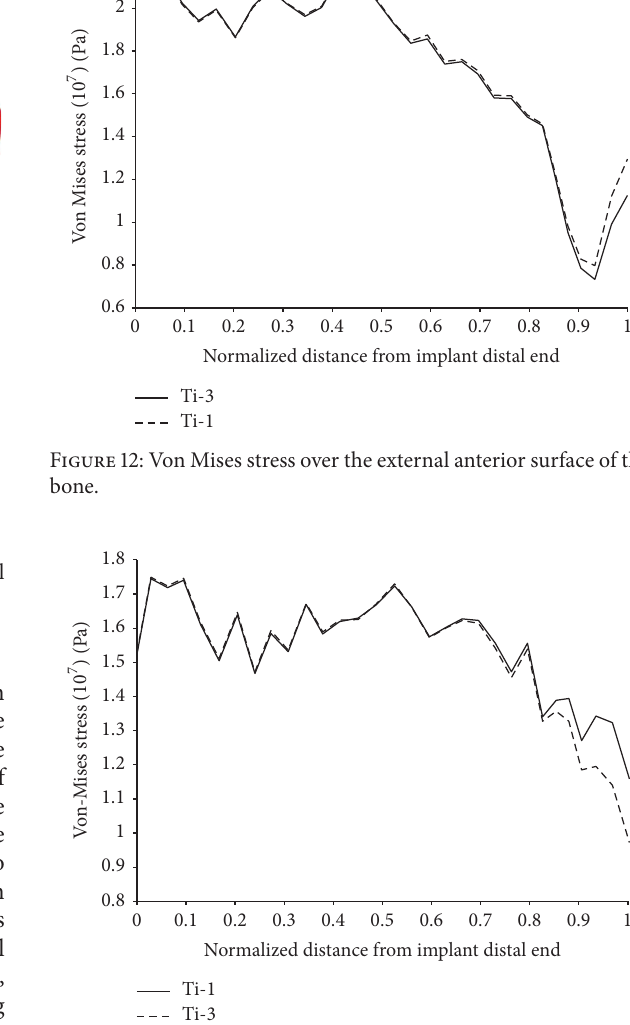
Figure 13: Von Mises stress over the external posterior surface of the